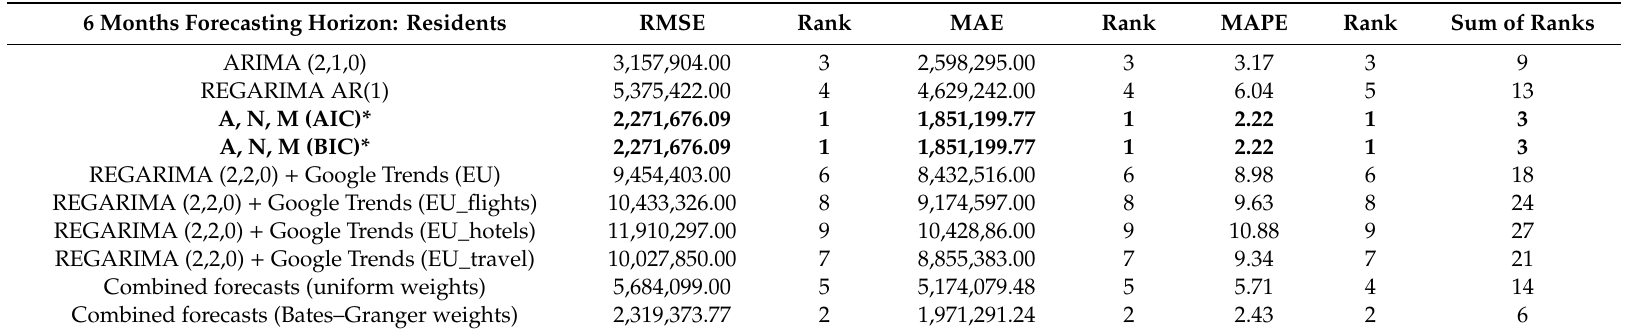
Table A8. Forecasting accuracy (December 2017): overnights, residents, six months ahead. Source: European Commission (2017) and own calculations. * AIC and BIC selected the same model. Boldface indicates the single forecasting model(s) / forecast combination technique(s) characterized by the lowest sum of ranks. 6 Months Forecasting Horizon: